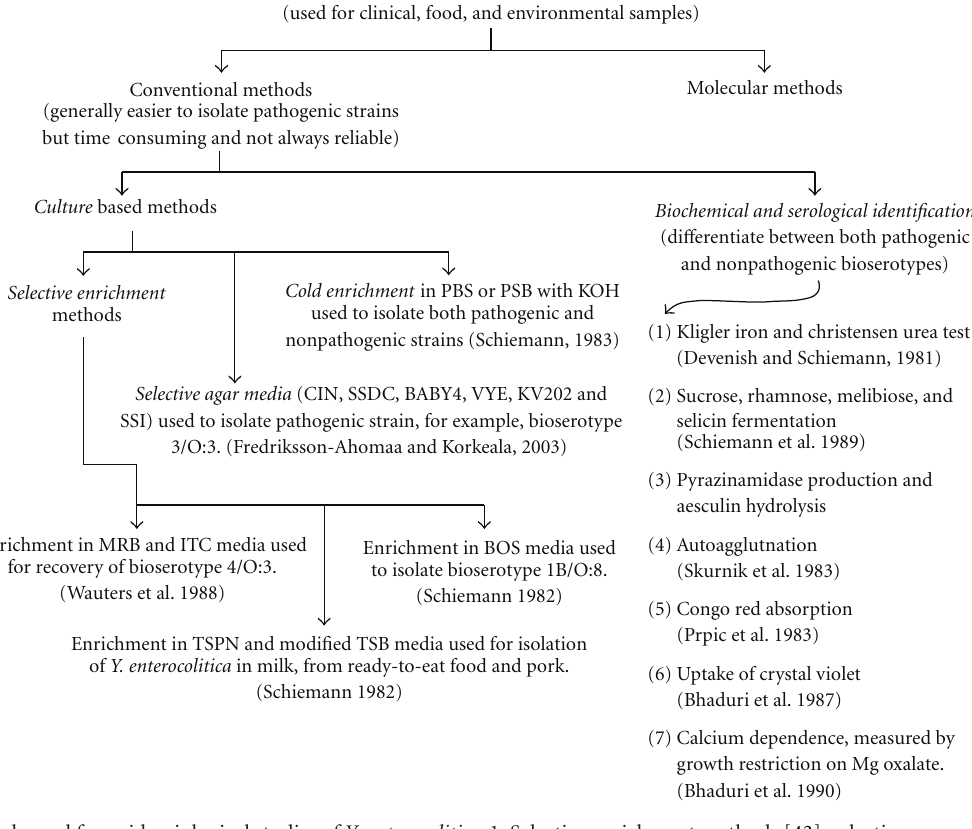
Figure 2: Methods used for epidemiological studies of Y. enterocolitica -1. Selective enrichment methods [43]; selective agar media [11]; cold enrichment method [57]; biochemical & serological identification methods [58–63]. (PBS: Phosphate bu ff ered saline; PSB: Phosphate- bu ff ered saline with sorbitol and bile salts; MRB: Modified Rappaport broth containing magnesium chloride, malachite green, and carbenicillin; ITC: Modified Rappaport base supplemented with irgasan, ticarcillin, and potassium chlorate; BOS: Bile-oxalate-sorbose medium; TSB: Tryptic soy broth; TSPN: TSB with polymyxin and novobiocin; CIN: Cefsulodin-irgasan-novobiocin; SSDC: Salmonella- Shigella deoxycolate calcium chloride; VYE: Virulent Yersinia enterocolitica ; SSI: Statens Serum Institute, Copenhagen, Denmark, enteric